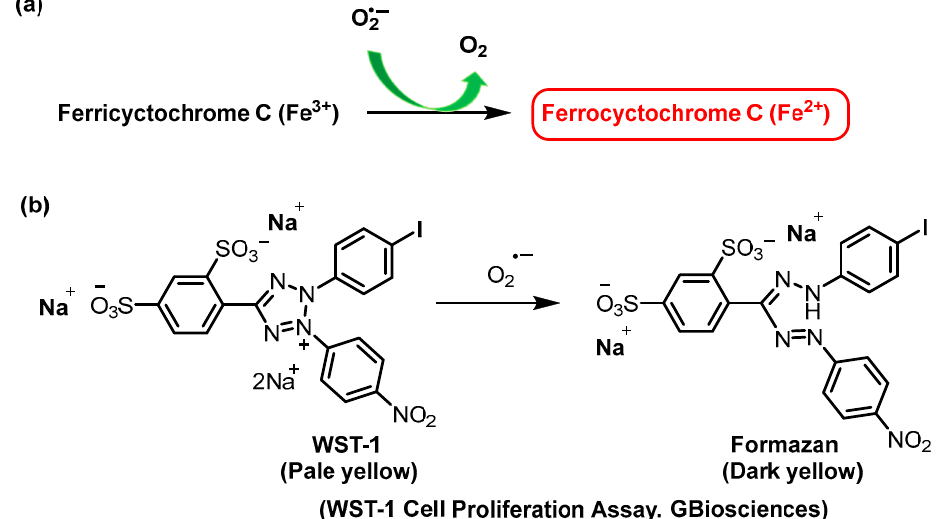
Figure 61. ( a ) Detection of O 2 •− by reduction of a cytochrome C system, ( b ) reduction of WST-1 in a formazan salt.